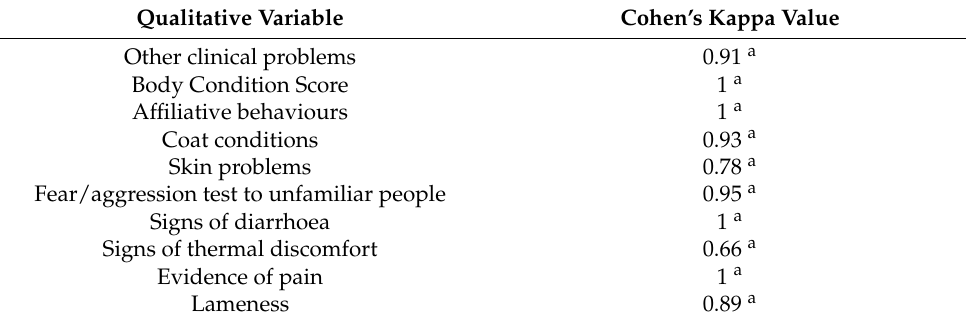
Table 4. Interobserver